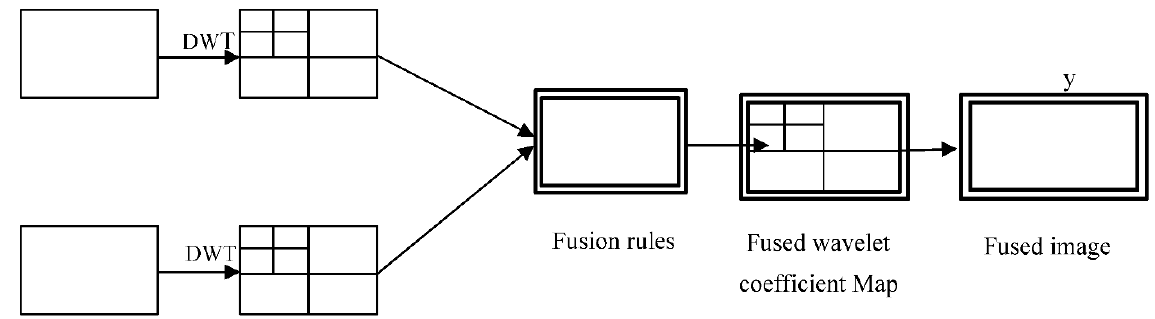
Figure 2. Optical DRPE encryption process (top) and decryption process (bottom).